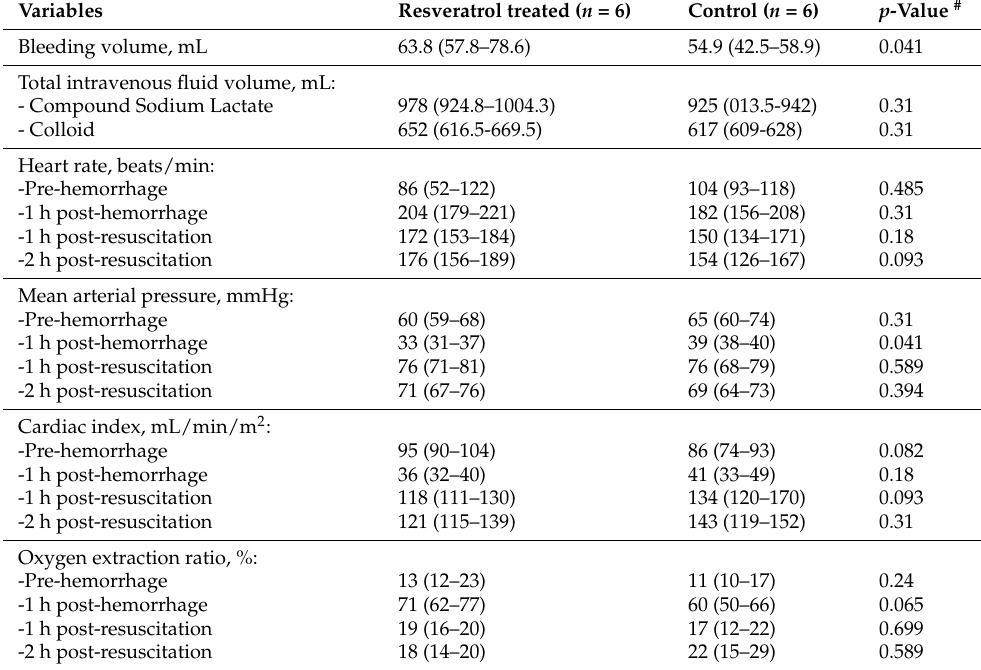
Table 5. Hemodynamic parameters, bleeding volume and intravenous fluid administered during the experiment ( n = 12).